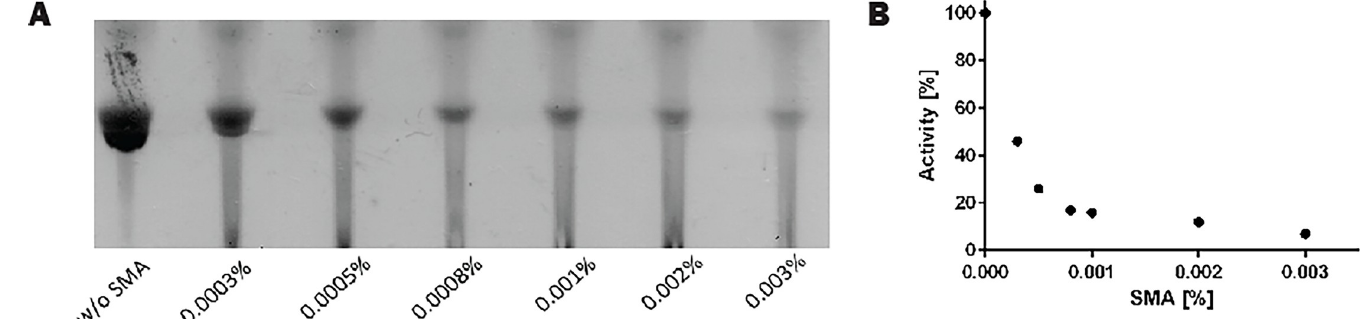
Fig 5. Effect of free SMA on Lipid II synthesis. (A) Lipid II synthesis with DDM-MraY (1 h incubation) visualized on TLC. First lane without adding free SMA. From second lane onwards increasing amount of free SMA was added; (B) Intensity of the spots on TLC shown in 5A was quantified using Image J and plotted against the concentration of SMA. Activity was set at 100% when no SMA was present. A dramatic drop of activity was observed as the SMA concentration increased.